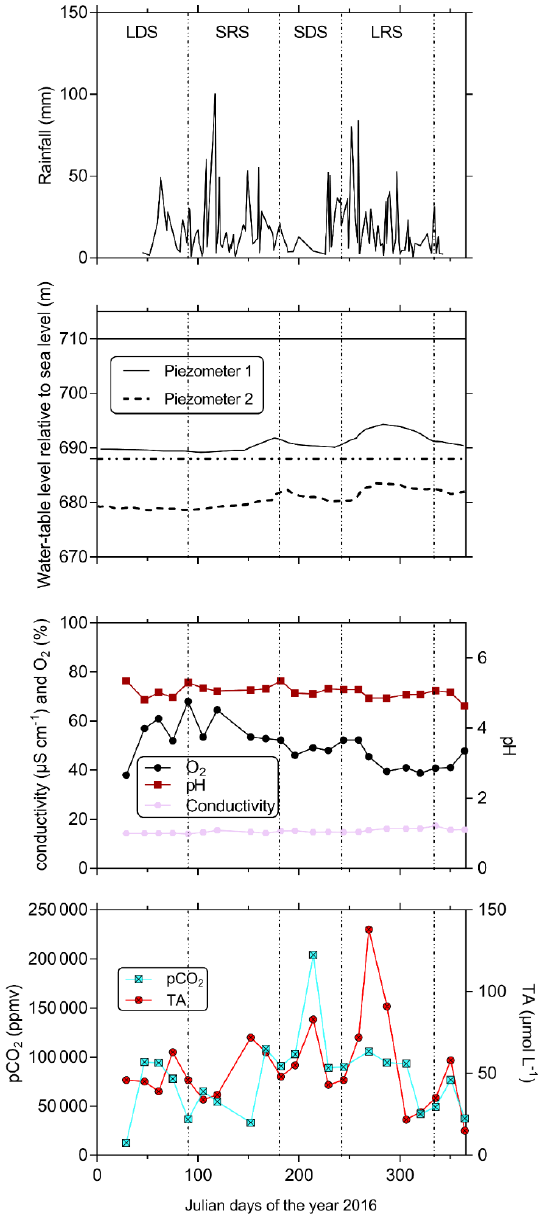
Figure 4. In the first-order Mengong catchment temporal variations in rainfall; water-table level in piezometers 1 and 2 (see Fig. 3b) rel- ative to sea level (elevation of the soil surface at piezometers 1 and 2 relative to sea level is also indicated by the horizontal lines); and p CO 2 , TA and ancillary parameters (oxygen saturation as O 2 , pH, conductivity as specific conductivity) in non-flooded forest ground- water (measured at the perennial source). The temporal variations are separated into the four seasons that occurs in the Nyong water- shed: LDS – long dry season, SRS – short rainy season, SDS – short dry season and LRS – long rainy season. Note, groundwater table level was retrieved from Nkoue-ndondo et al.